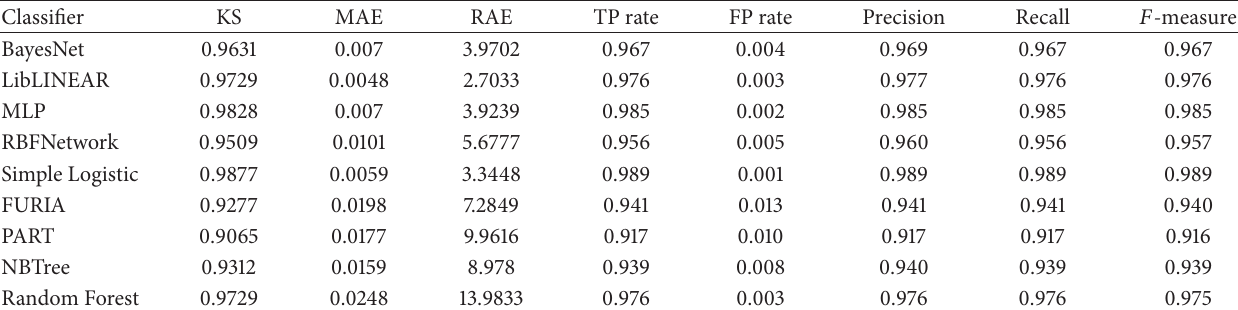
Table 4: Statistical performance analysis and weighted average of the measuring parameters are shown here.